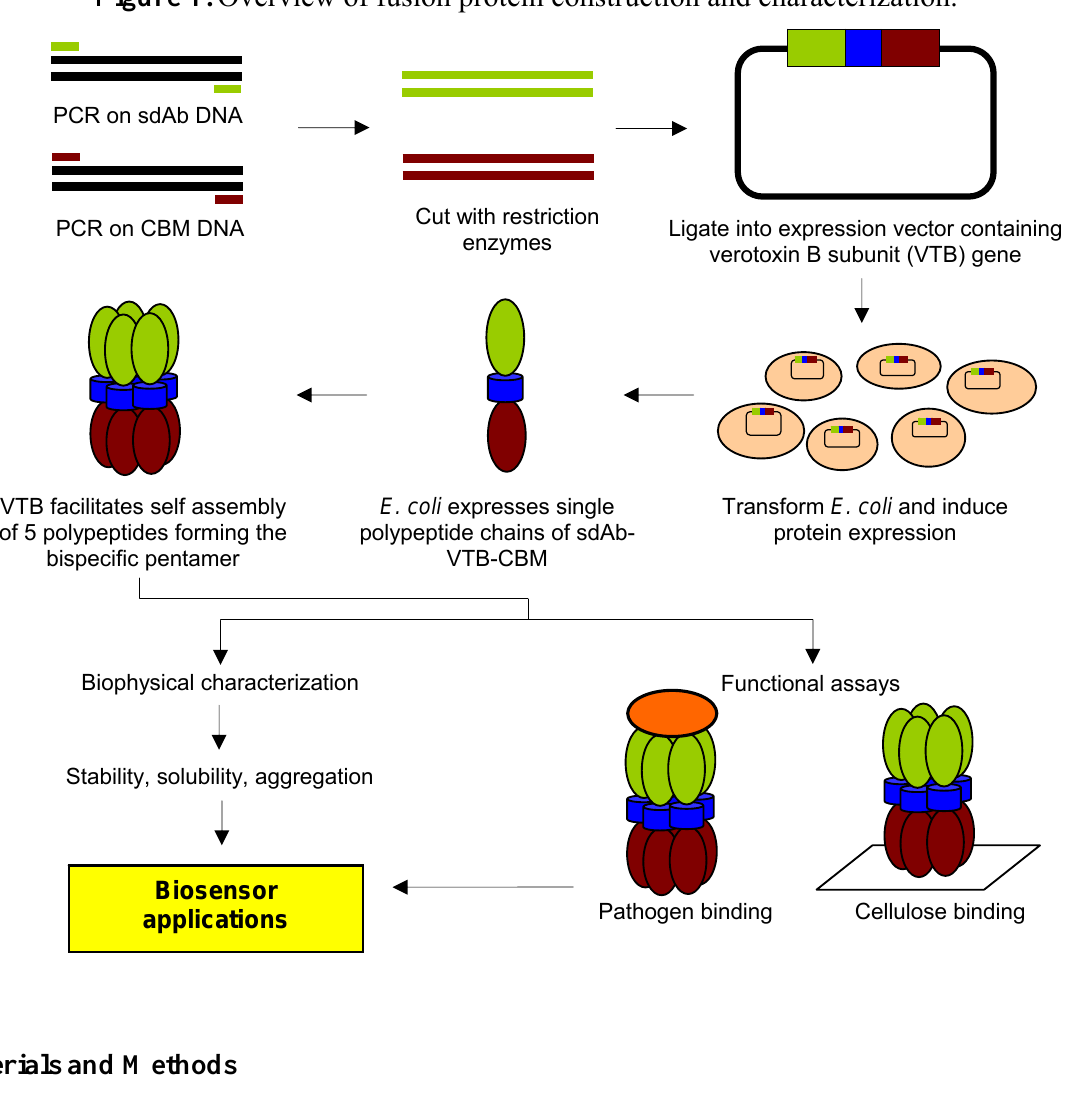
Figure 1. Overview of fusion protein construction and